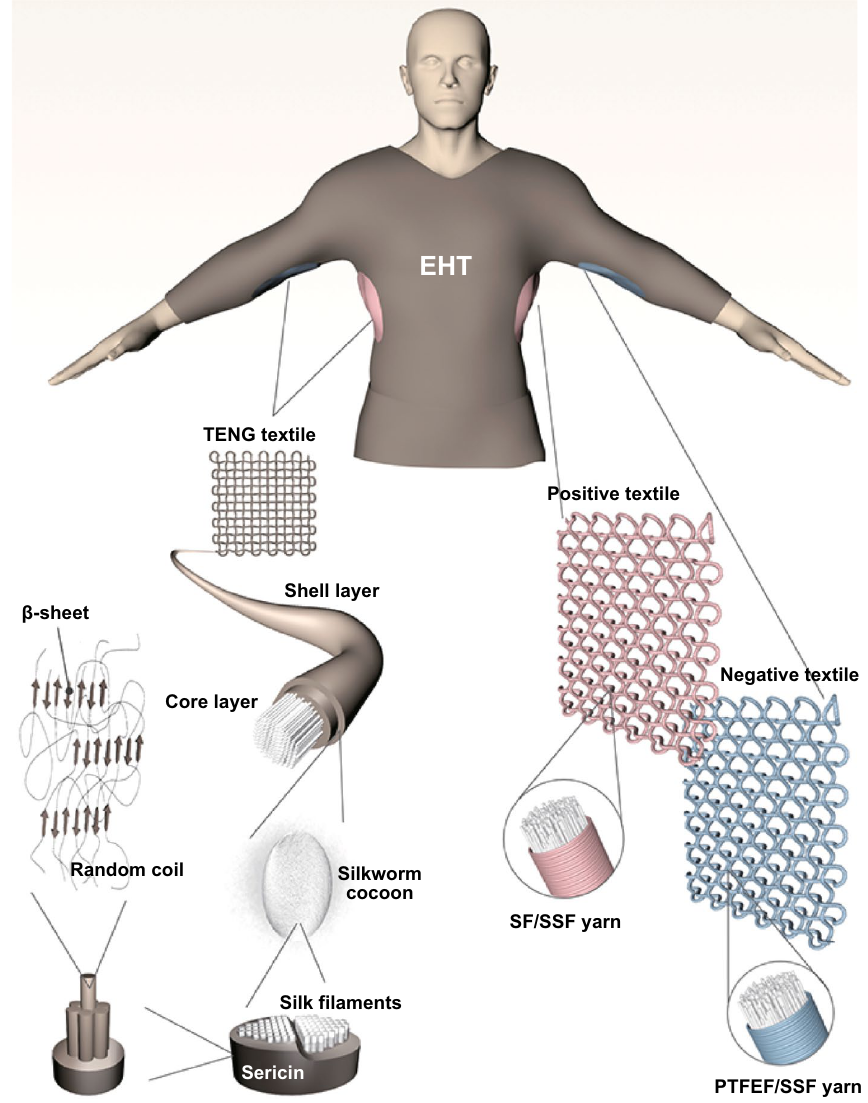
Fig. 1 Schematic illustration of the SF/PTFEF